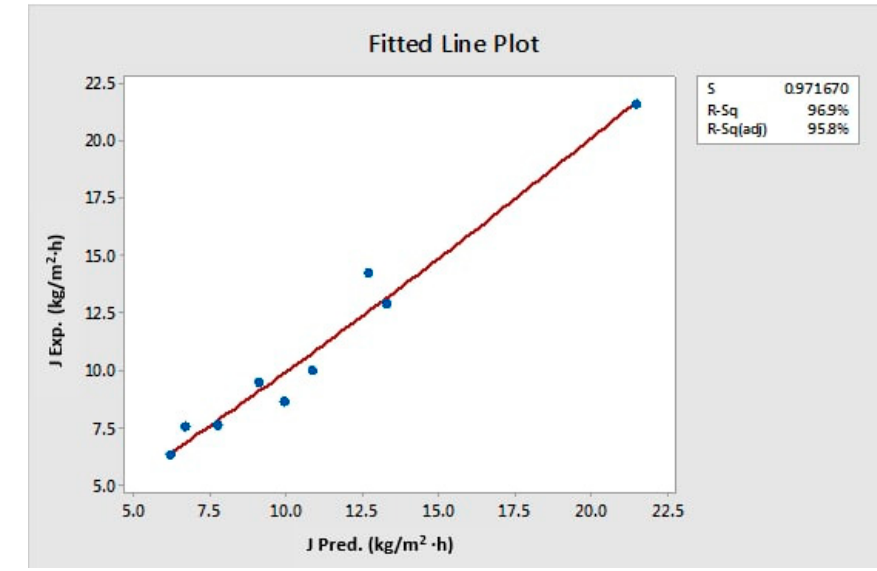
Figure 12. Predicted versus experimental values of the